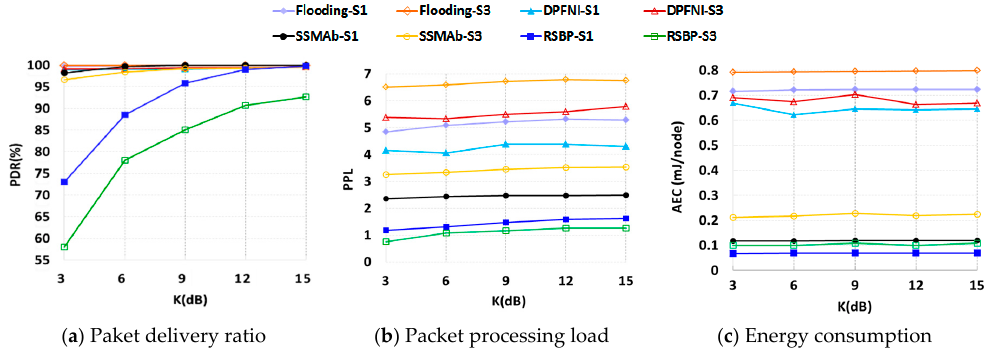
Figure 11. Comparison of different protocols with varying K ( N = 4).